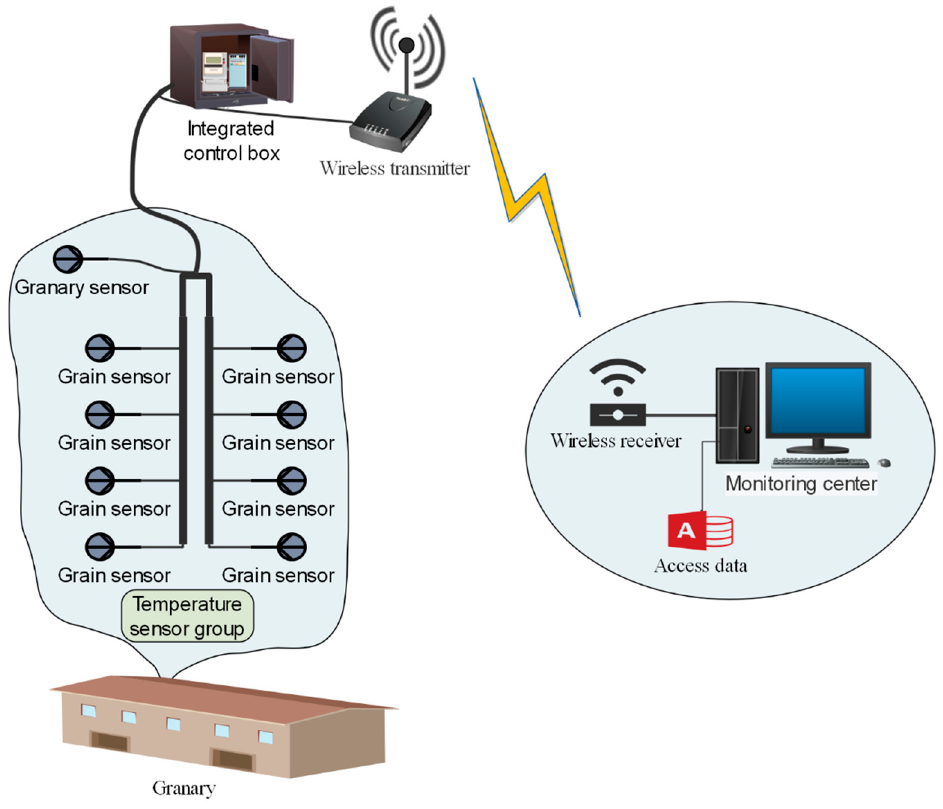
Figure 2. The structure of a digital wireless grain condition monitoring system. The width of the granary was generally 18–36 m and the length was 36–60 m. The headspace above the grain surface was not less than 1.8 m. The wall material was a reinforced concrete structure and the roof was made of a heat preserving material. In the granary, the temperature sensors layout was as follows: The distance between the rows and columns of the horizontal temperature measuring cables should be no more than 5 m; the distance between the vertical sensors should be no more than 2 m; and the distance from the cables to the grain surface, granary bottom, and granary wall should be within 0.3 m to 0.5 m.